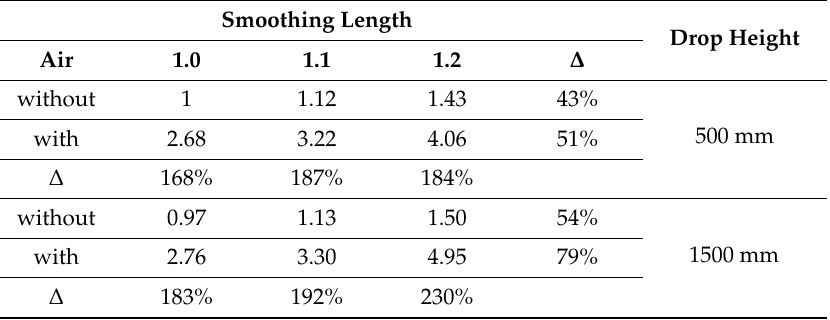
Table 3. Analysis time for different smoothing length ( h ), drop height and air particles cases (with values expressed by a multiplication factor respect to a base-time ( t 0 ) equal to 116 minutes for an Intel i5-4590 3.3 GHz processor with 32 GB).